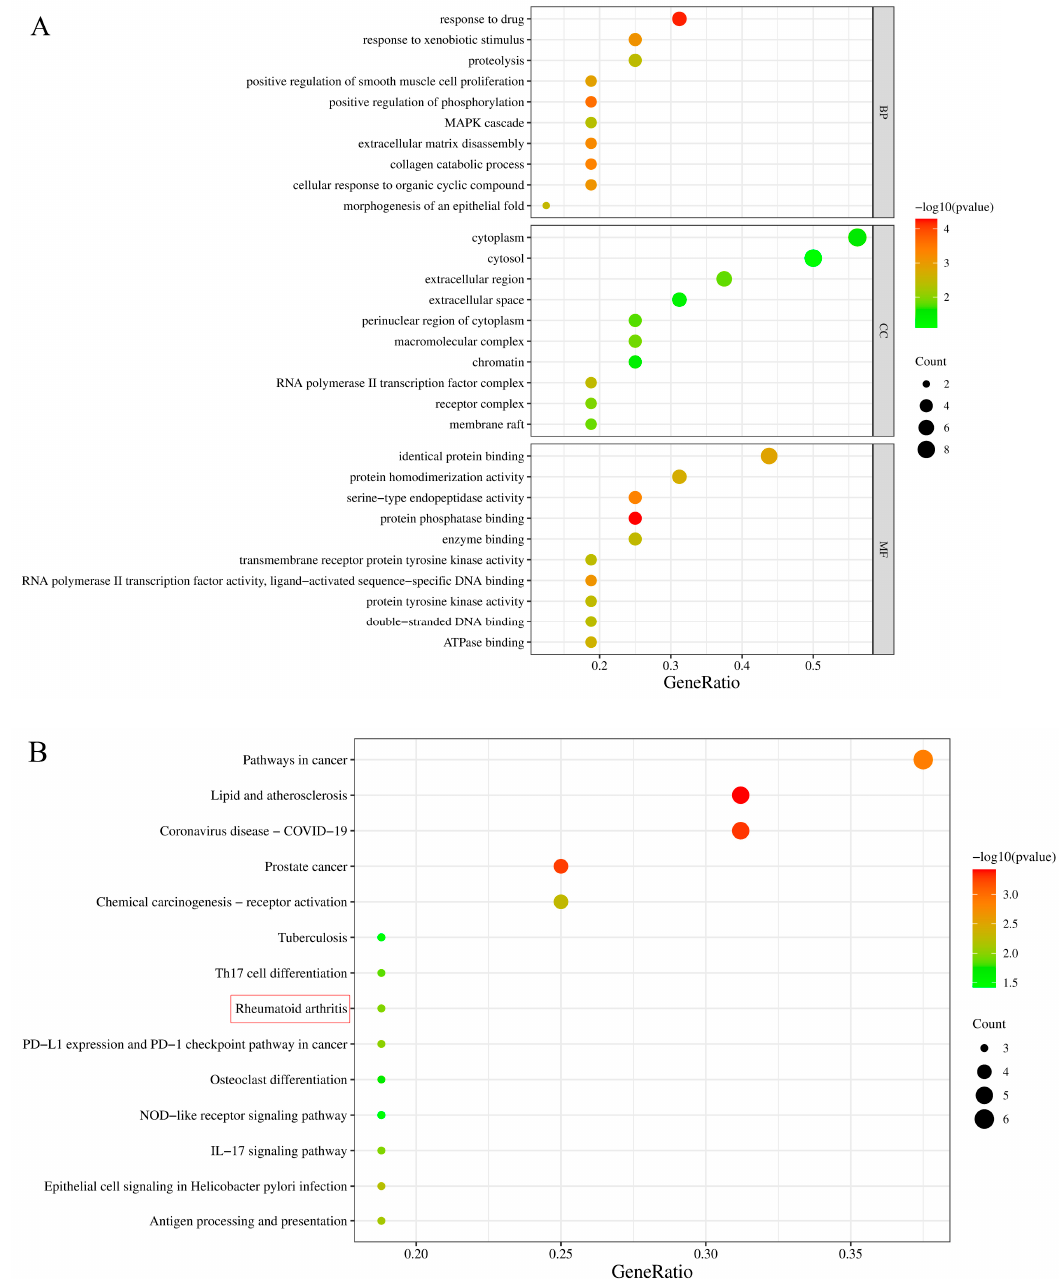
Figure 7. The functional characterization of potential targets of purpurin against RA. ( A ) Gene ontology analysis of potential targets of purpurin, biological process (BP), cell component (CC), molecular function (MF). ( B ) Kyoto Encyclopedia of Genes and Genomes (KEGG) pathway of potential genes of purpurin.